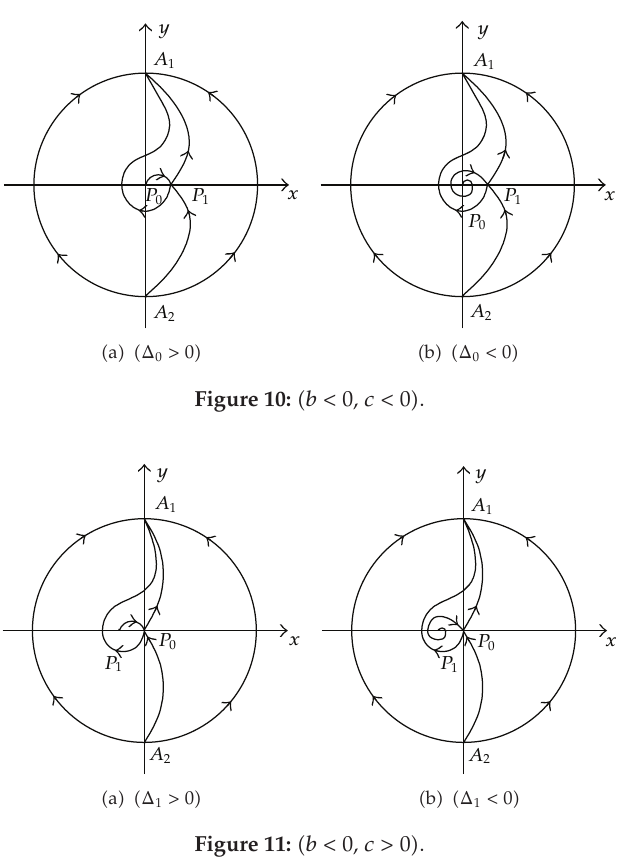
Figure 10: (cid:6) b < 0, c < 0 (cid:7) .